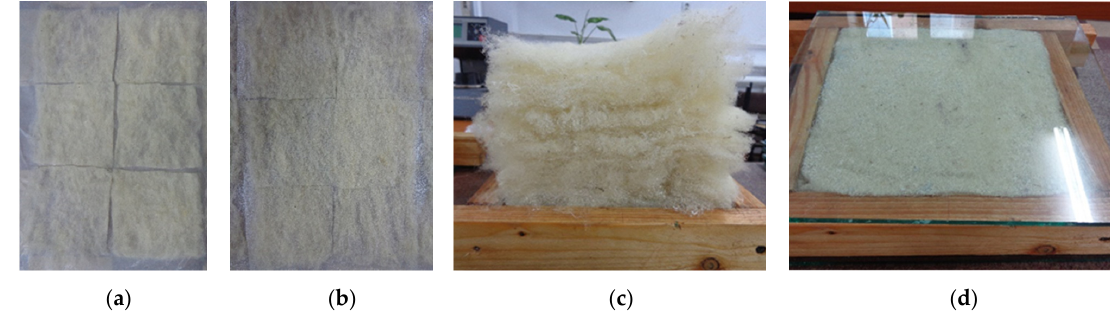
Figure 5. Making the specimens P1-P12 by spraying the binder over the fibres: ( a ) fibre mats cut to size; ( b ) binder sprayed over fibres; ( c ) mats arranged in formwork; ( d ) pressed formwork. In the second method of making the wool-binder samples, the panels were obtained by mixing the component materials. The preparation of the samples started by distrib- uting the required amount of wool on a flat surface, after which the mats were cut to the final panel size. The thickness of the mats at this stage was not relevant because the carded fibres of the mats were arranged in one direction and the thickness control of the individ- ual layers was easier after the mixing process. After preparation of the wool mats, they were transferred one by one to a metal tray where they were sprinkled with a small amount of binder, the sprinkled mats being arranged one on top of the other. A cylinder was formed by tightly winding the layers together, starting the process at a random side of the assembly. The cylinder was then unrolled, and the winding of the layers on the opposite side of the assembly was repeated. These steps of wrap–unwrap–wrap were car- ried out for the 2 opposite sides and 2 diagonals until it was found that the dispersion of the binder was uniform. This obtained assembly was easily unrolled into thin layers, which were arranged in a formwork. The making of the samples by mixing is shown in Figure 6.